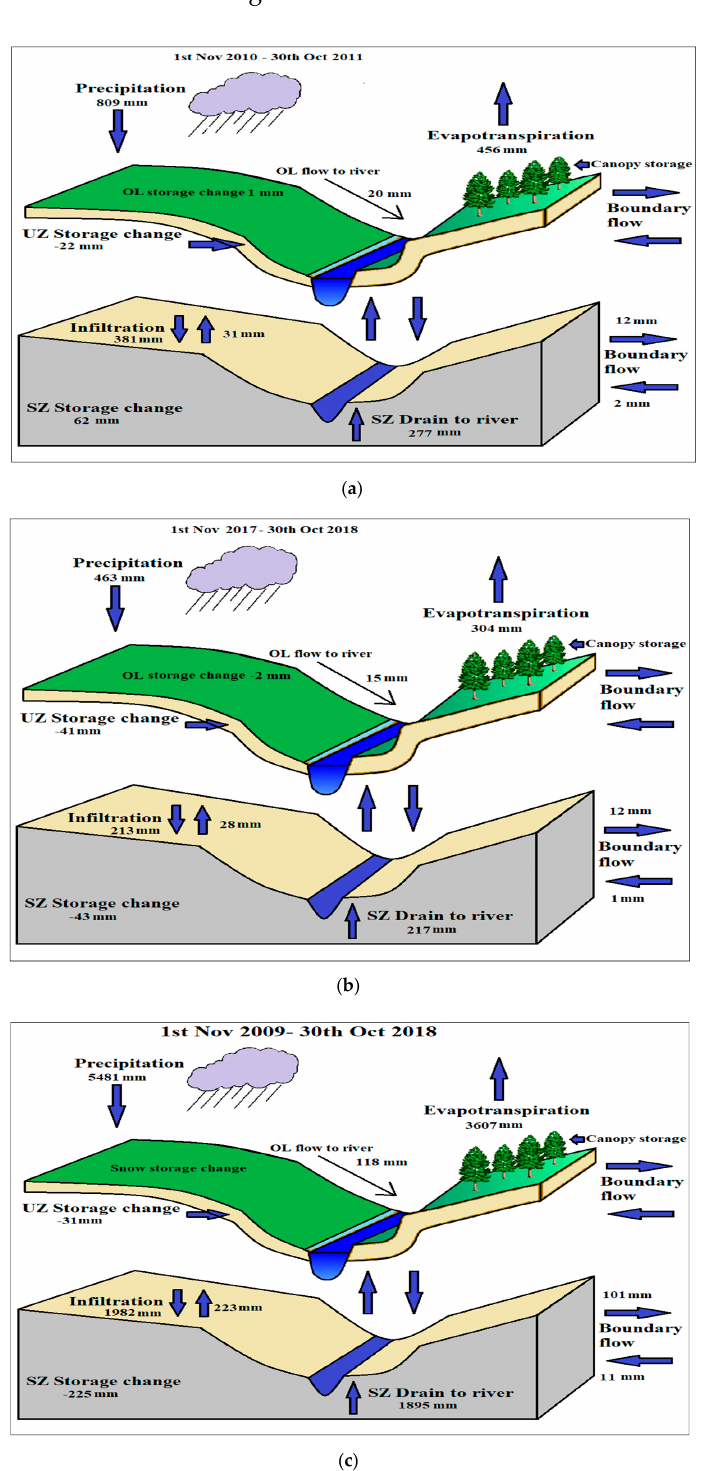
Figure 12. Water balance for the Tollense river catchment (400 km 2 ) during wet hydrological year 2010-11 ( a ); dry hydrological year 2017–2018 ( b ); total water balance from 2010–2017 ( c ). All figures are in millimetres, where positive and negative storage change represents the ascending and descending change in water stored in SZ and